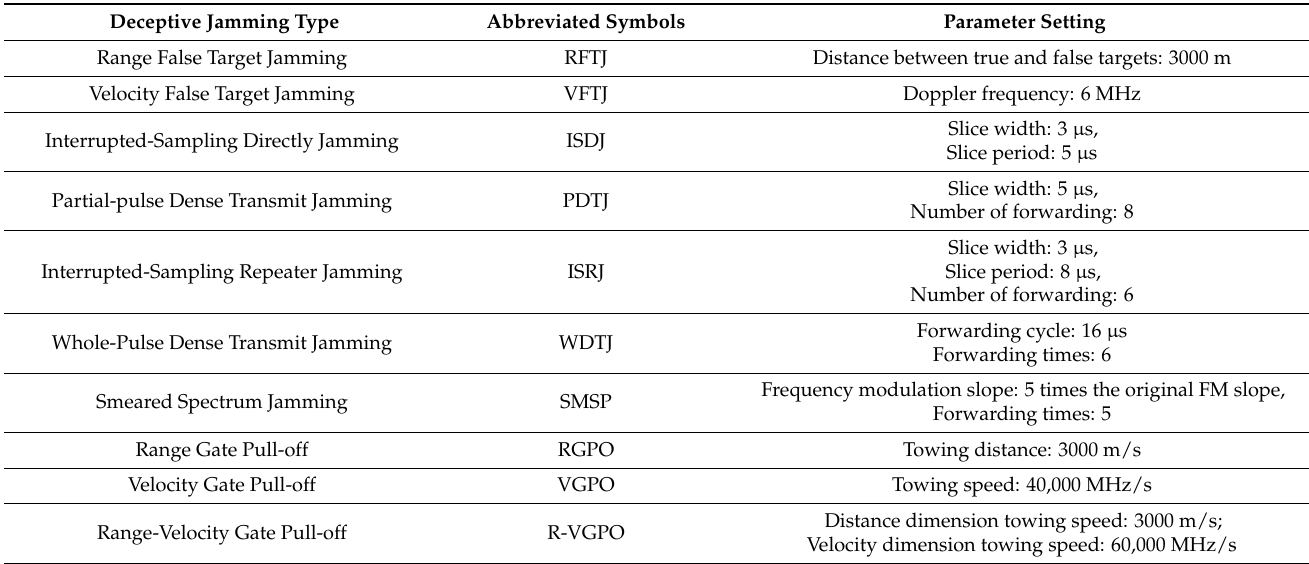
Table 2. Simulation parameters of jamming